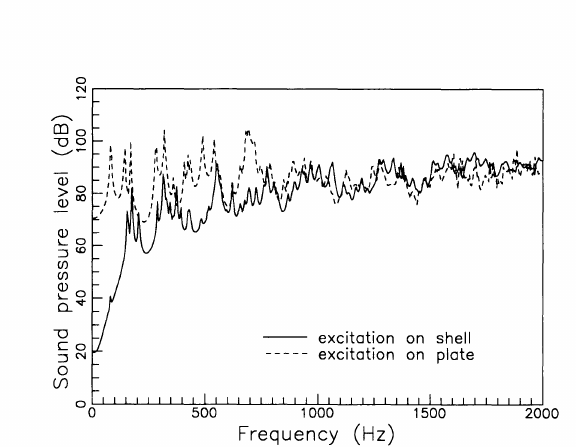
FIGURE 8 A verage sound pressure levels inside the cavity generated by the motion of the structure with the shell and the end plate, respectively, subjected to a unit point load.